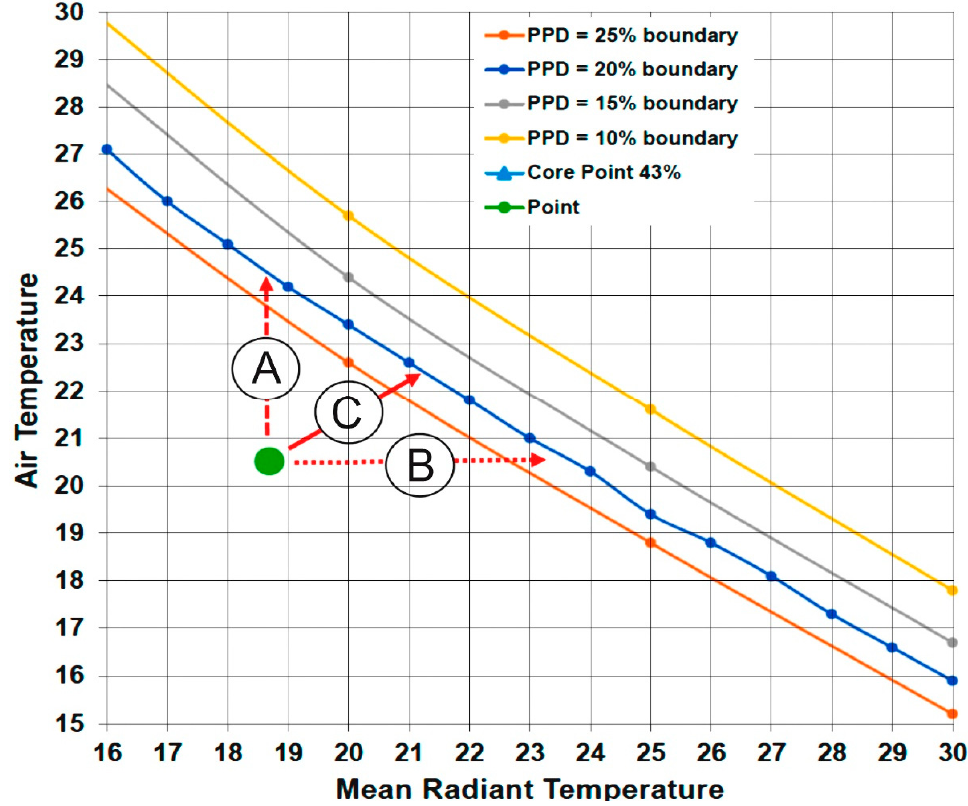
Figure 7 . Air temperature vs. mean radiant temperature concerning PPD [25]. Source: Redrawn by the second author.